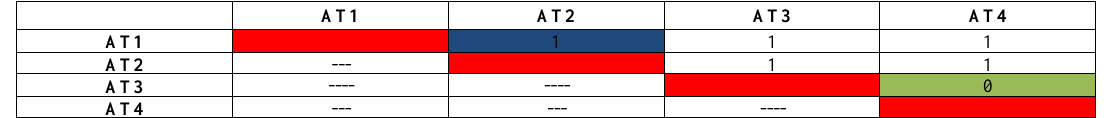
Table 16. Dominating interaction matrix of actors for process